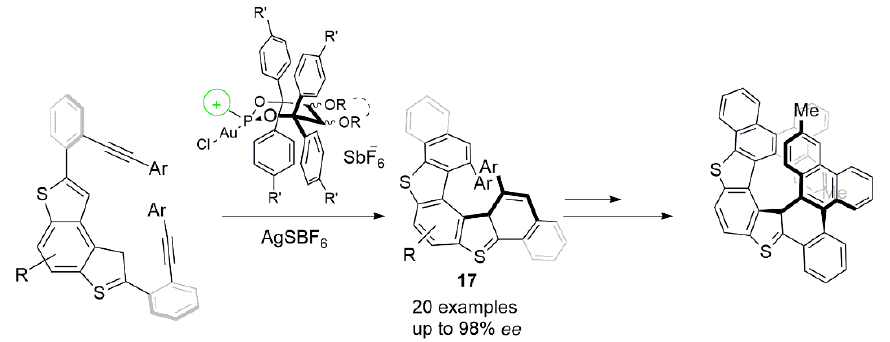
Figure 10. Enantioselective synthesis of dithia[5]helicenes ( 17 ).